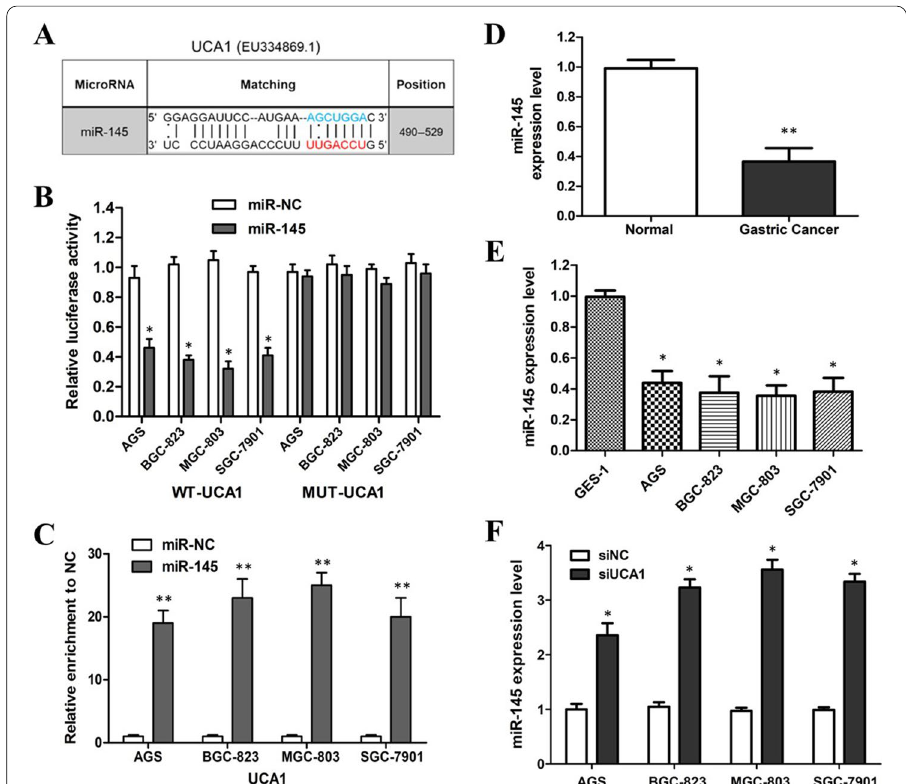
Fig. 6 UCA1 acts as a sponge of miR-145 in GC. A Putative binding site of miR-145 on UCA1. The red nucleotides were the seed sequences of miR-145 and the blue nucleotides were deleted in the MUT-UCA1. B Dual-luciferase reporter assays of GC cells co-transfected with WT/MUT UCA1 and miR-145 mimics or miR-NC. C RIP assay showed that both UCA1 and miR-145 existed in the production precipitated by anti-AGO2. D miR-145 expression levels in GC tissues and normal tissues. E miR-145 expression levels in GC cell lines. F. Knockdown of UCA1 increased the expression level of miR-145 IN GC cell lines. *p < 0.05, **p < 0.01, compared with control